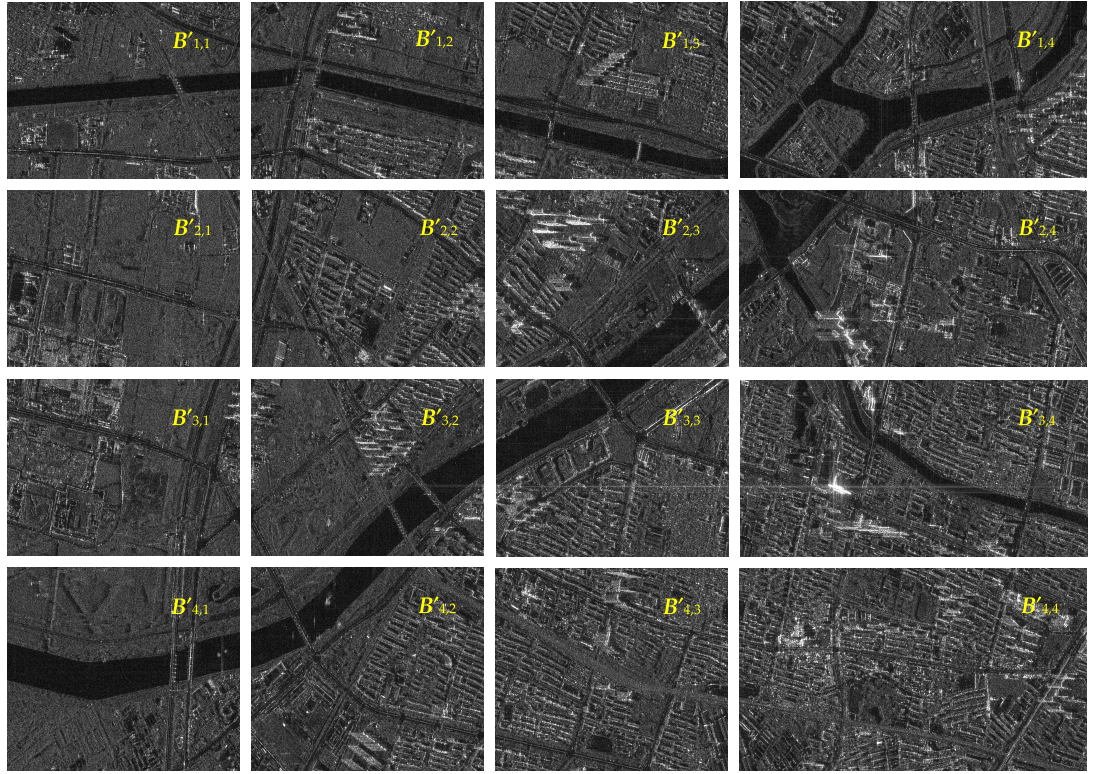
Figure 5. Partitioned sub-image blocks with shared boundary regions. Remote Sens. 2020 , 12 , x FOR PEER REVIEW